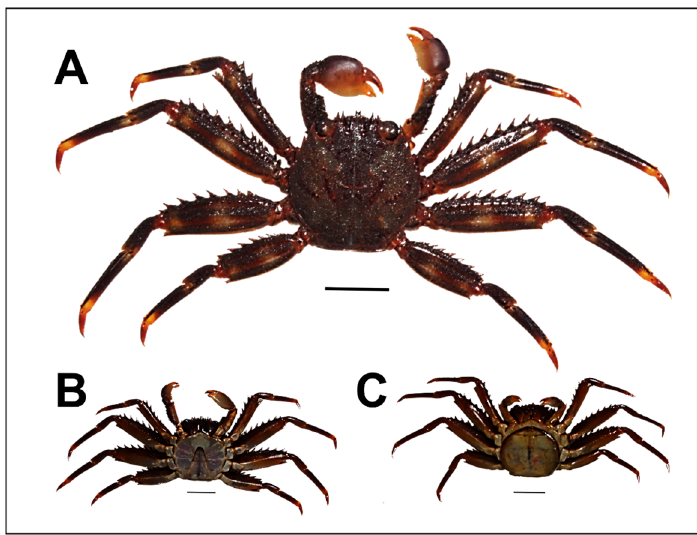
Figure 1. ( A ) Specimen of Percnon gibbesi. Male ( B ) and female ( C ) according to the abdomen shape. Scale bar = 1 cm.